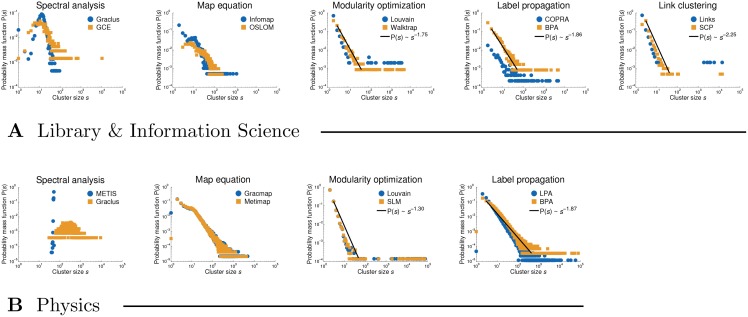
Size distributions of the clusterings obtained by representative methods.Panels A and B show cluster size distributions P(s) for the Library & Information Science and Physics citation networks, respectively. Wherever plausible, the power-laws s−γ are fitted to the tails of the distributions by maximum likelihood estimation, γ = 1 + n (∑i log si/smin) for smin > 1.